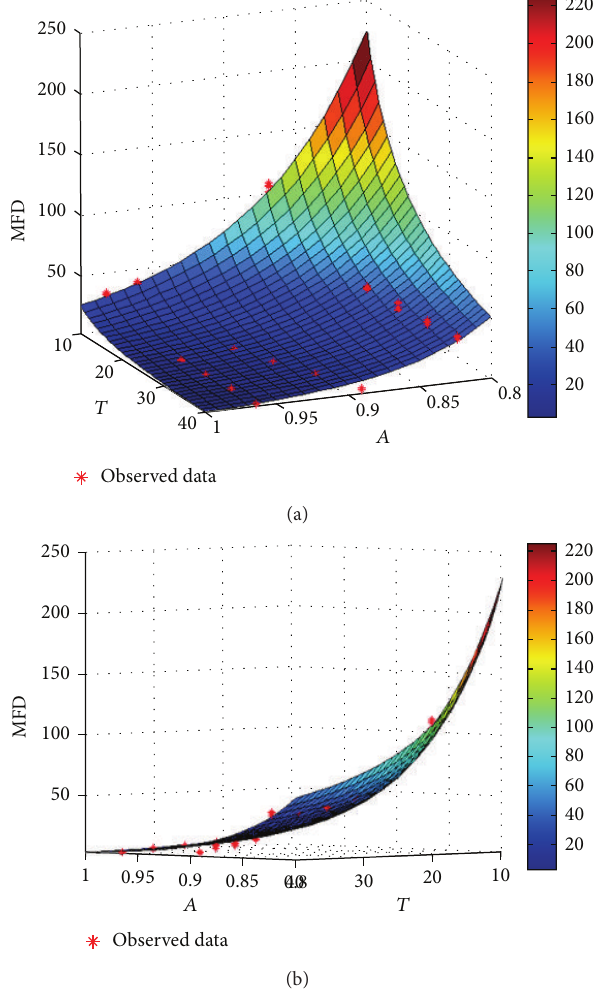
Figure 6: (a) Prediction model for the median number of mold- free days (MFDs) based on temperature ( 𝑇 ) and water activity ( 𝐴 ) values obtained from the Weibull distribution utilizing observed logarithmic values of 𝑇 , 𝑎 𝑤 , and an interaction term of 𝑇×𝑎 𝑤 of three replications. Observed mold growth expressed as mold-free days (MFDs) on soy/PE fiber samples from all three replications shown as points on the graph to demonstrate the relationship of observed values to the predicted values. (b) A side-view of